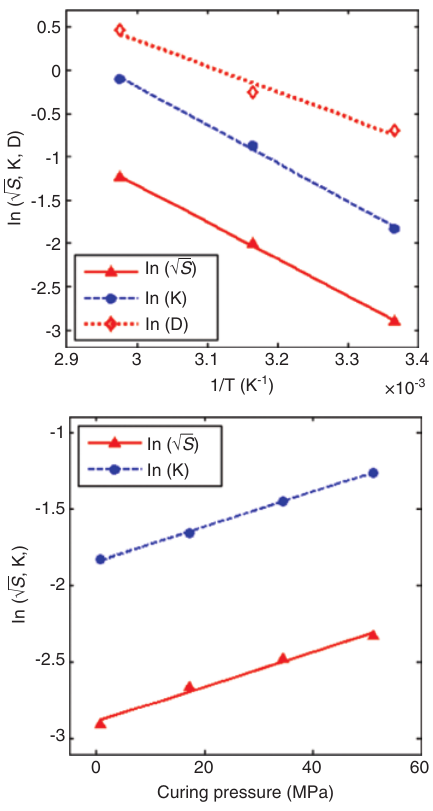
Figure 10: Temperature and pressure dependence of the fitted model parameters (Class H-P cement, w/c =